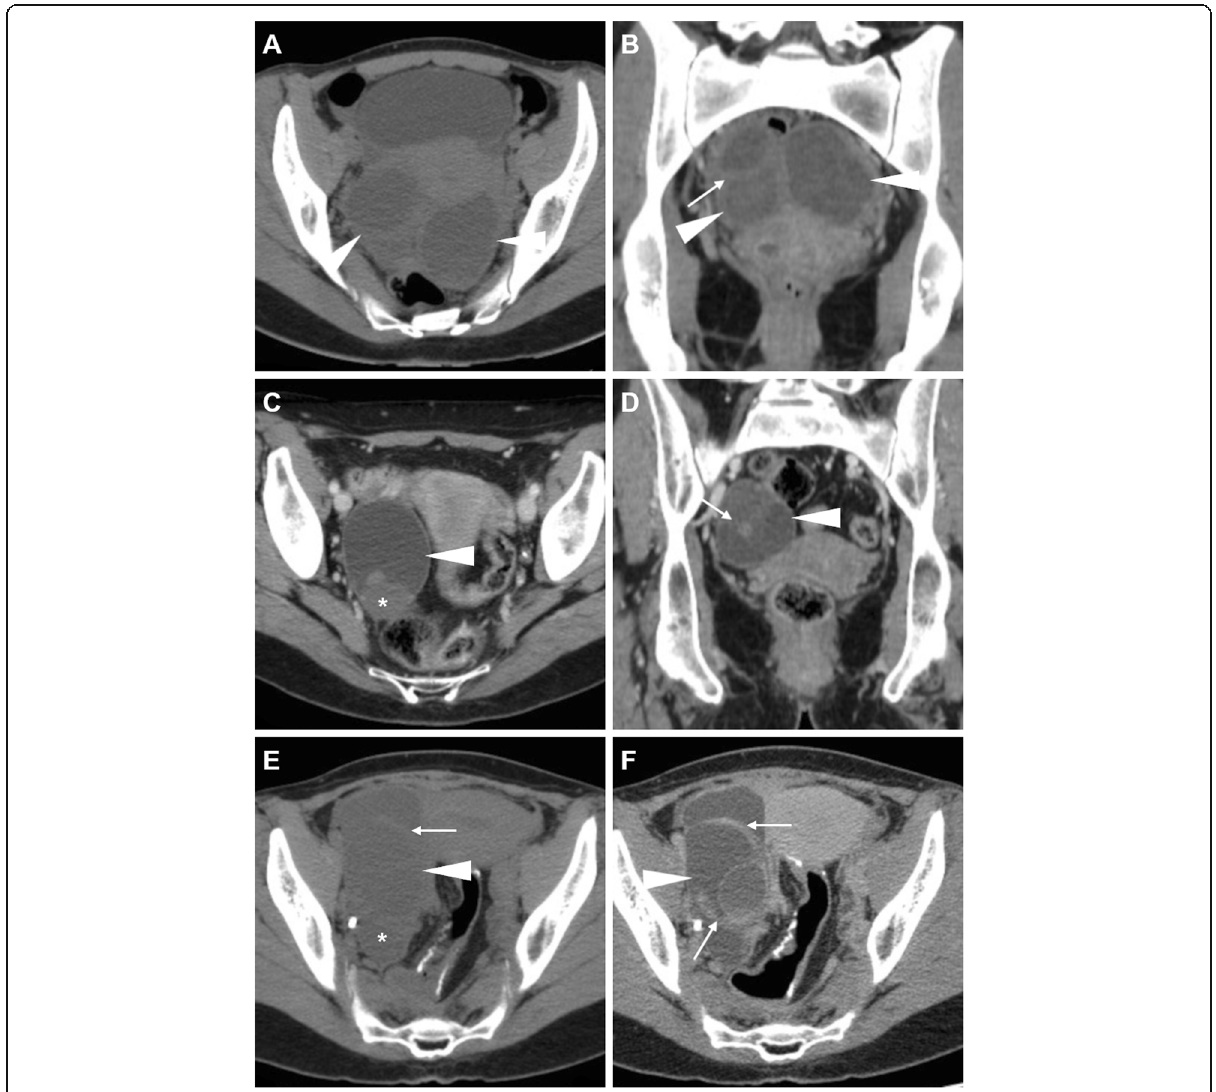
Fig. 9 Key CT differential diagnoses of haemorrhagic ovarian cysts. a , b Unenhanced ( a ) and postcontrast ( b ) CT images of bilateral endometriomas (arrowheads) occupying the rectouterine pouch in a ‘ kissing ovaries ’ configuration. Note the mildly inhomogeneous attenuation and septation (thin arrow in b ). c , d Ovarian carcinoma in a premenopausal woman with predominantly cystic pattern, septations (thin arrow in d ) and a solid, enhancing eccentric mural vegetation (asterisk in c ). e, f Unenhanced ( e ) and post-contrast ( f ) images of a postoperative collection (complex serocele, arrowheads) involving the adnexal region, showing septations (thin arrows). Note the right ureteral stent and suture at the sigmoid colon after multiple surgeries for Crohn ’ s